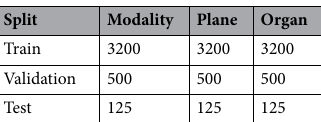
Table 2. Train, validation, and test splits for the yes-no type question-answer pairs in MED-VQA